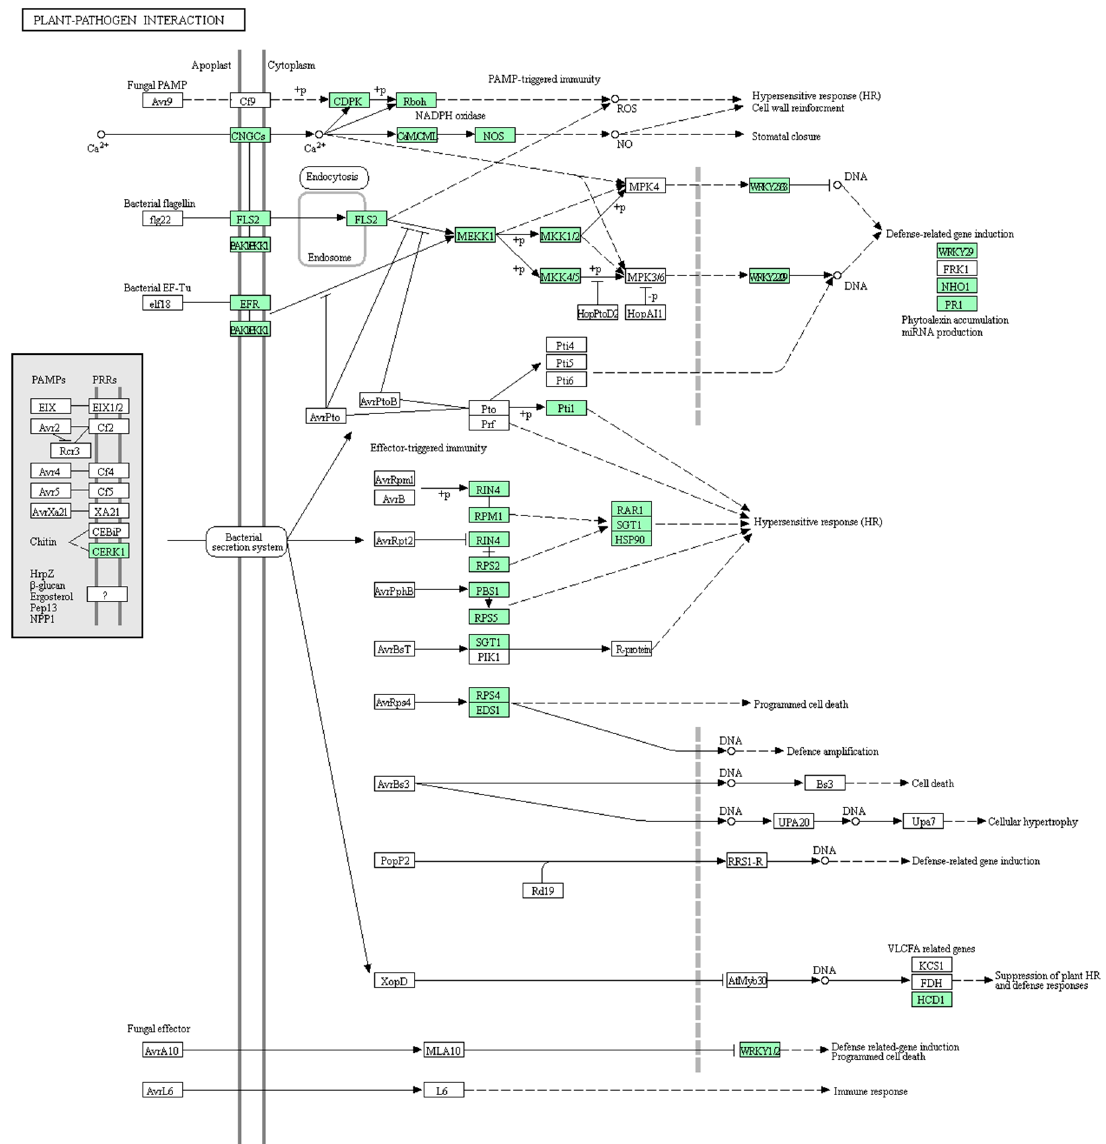
Figure 5. Schematic of the pathway category ‘Plant-pathogen interaction’.